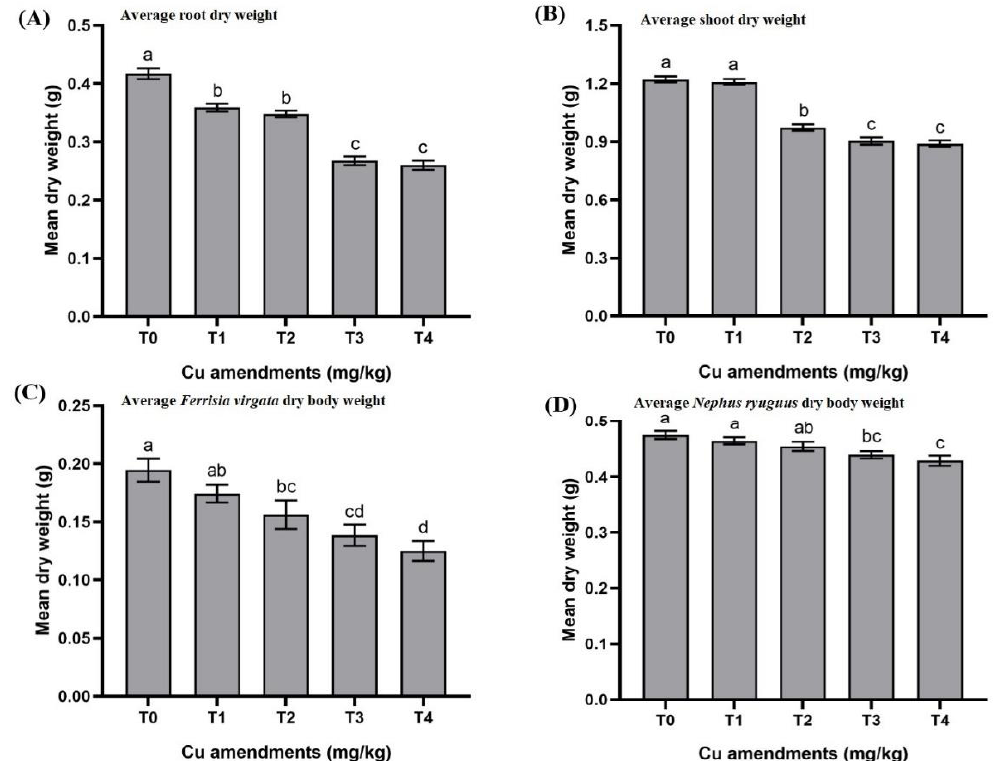
Figure 3. ( A – D ) Changes in mean dry weights of different trophic levels of food chain in response to soil amendment with different Cu concentrations. T0 = control, T1 = 100, T2 = 200, T3 = 400 and T4 = 800 mg/kg. Each value is the mean of three replicates ± S.E. Bars with different letters are significantly different at p < 0.05.